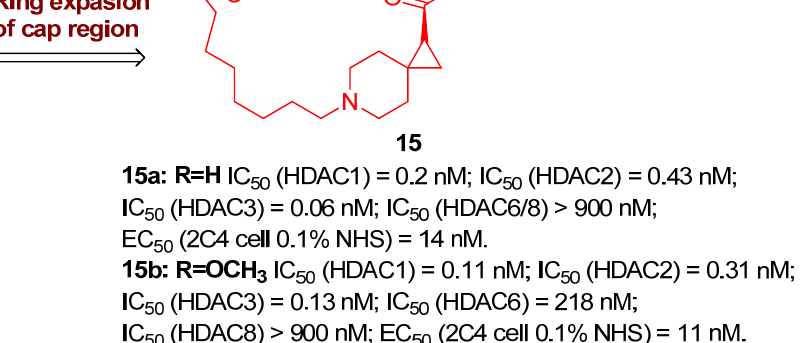
Figure 4. Class I-selective macrocyclic HDACIs 15 developed from Apicidin.